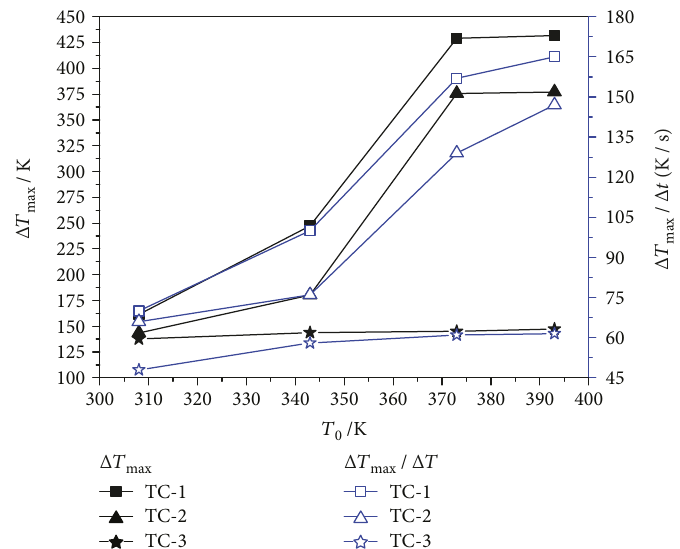
Figure 11: E ff ect of air fl ow temperature on the maximum temperature increase and maximum rate of temperature increase at combustor